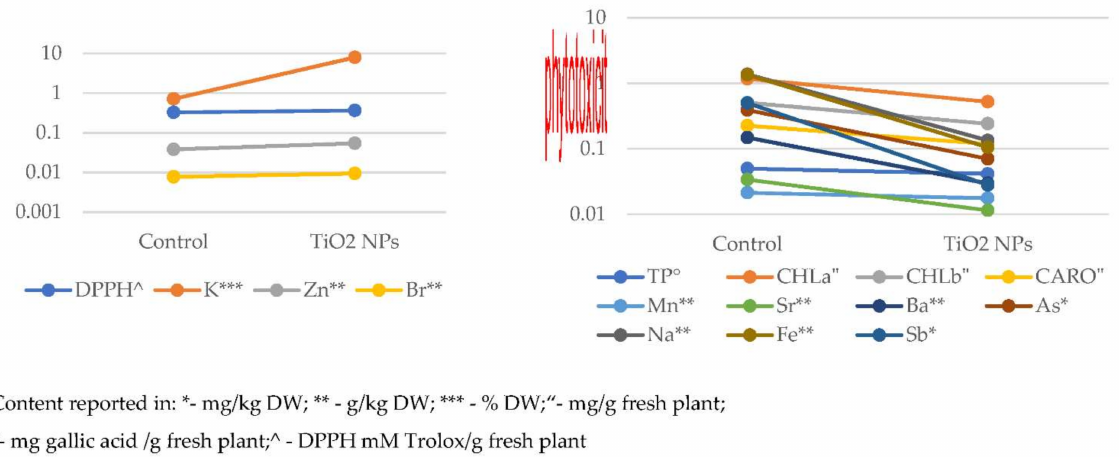
Figure 10. Graphical representation of the variation of the content of bioactive compounds and chemical